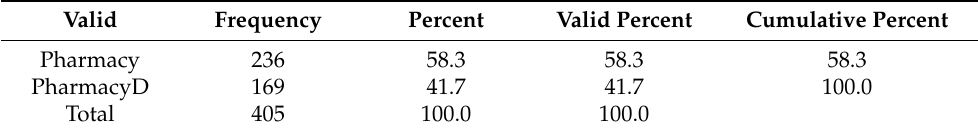
Table A3. Course enrolment distribution.